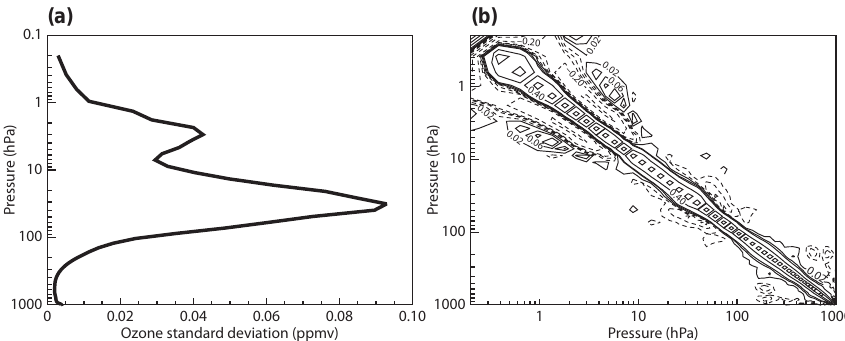
Figure 3. Example of ozone background error standard deviation profile (a) and vertical correlation matrix (b) for the ozone background errors. Data are given as mixing ratio (parts per million by volume, ppmv). In panel (b) , negative correlations are plotted as dashed lines, and the interval is 0.04ppmv between − 0.1 and 0.1ppmv and 0.2 for larger absolute values. Source: Dragani and McNally (2013). Table 3. Major differences between the ozone analysis system used in this paper and those of the ERA-Interim and the MACC reanalyses. Detailed information on the set-up of these two reanalyses can be found in the corresponding literature. For the ozone-specific differences, an indication of the region of the atmosphere where an impact is expected is indicated in the fifth column. There, the letters ST and TR stand for stratosphere and troposphere,